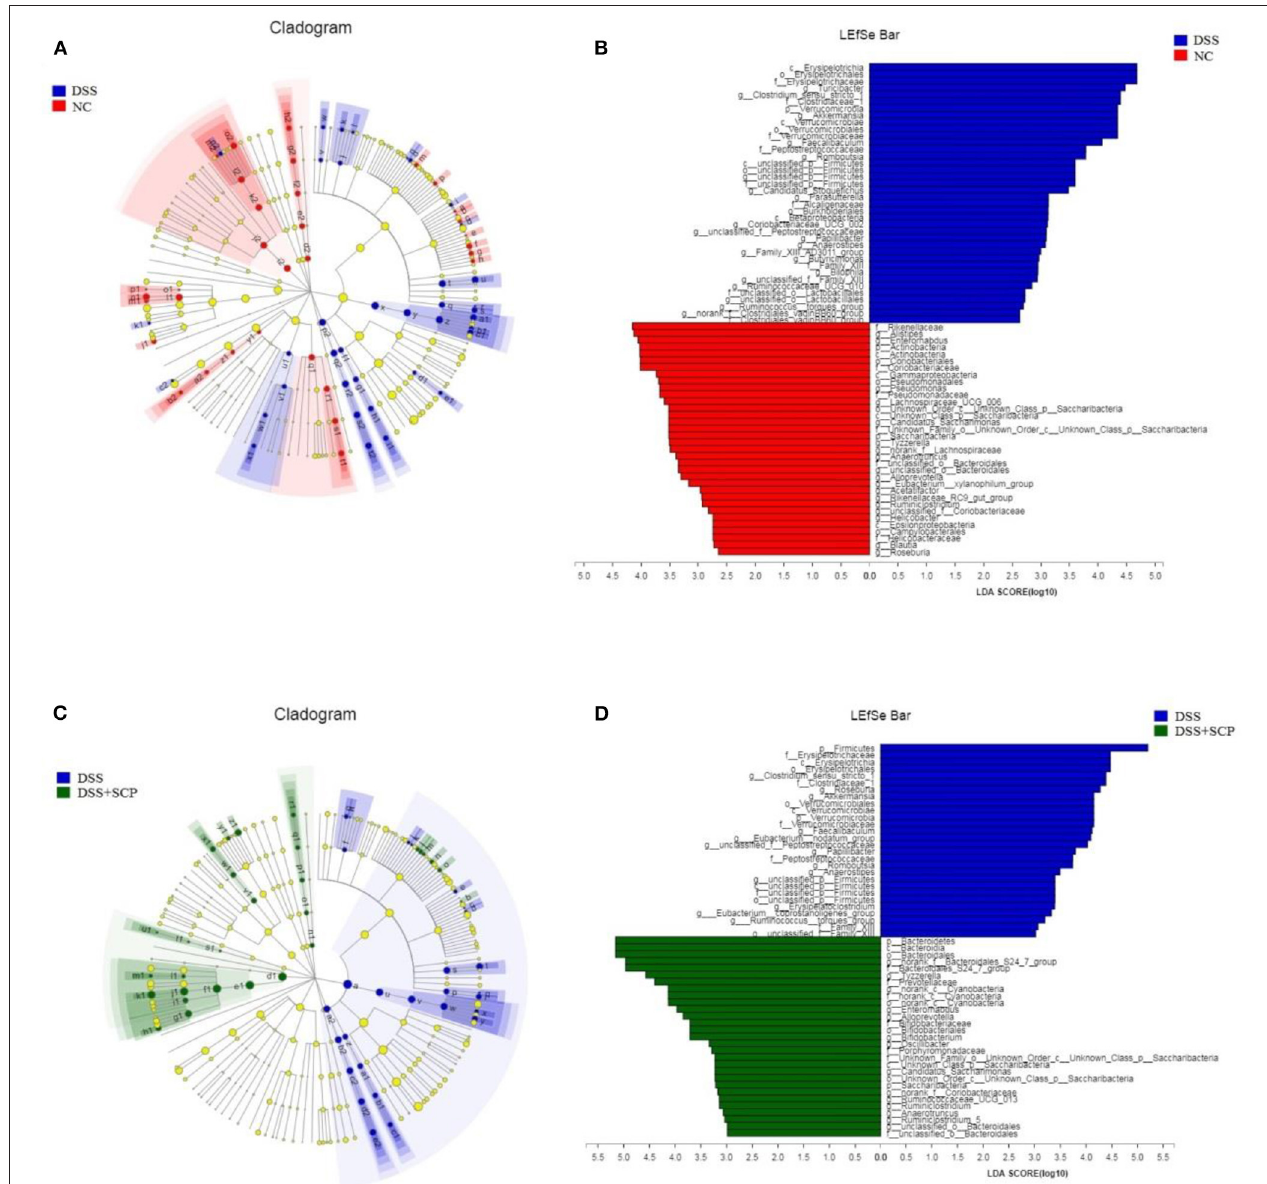
FIGURE 8 | (A–D) Cladograms indicating the polygenetic distribution of bacterial lineages associated with the different groups. Indicators between inner and outer mangrove sediments with LDA score larger than 2.5. LEfSe provided the features that are differential bacterial taxa ranking according to the effect size. Different color nodes represent the microbial groups that are significantly enriched in corresponding groups and have significant influence on the differences between groups. The light yellow node indicates the microbial groups that have no significant difference in different groups or have no significant influence on the differences between groups.